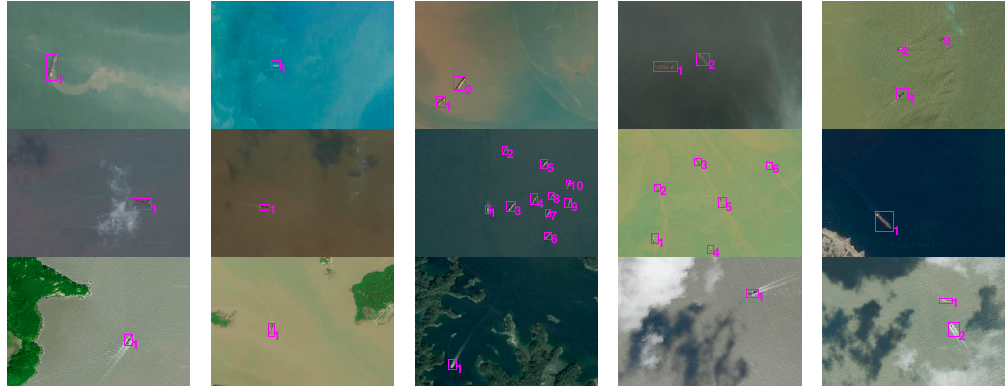
Figure16. The final detection results after the multi-level discrimination. Figure 16. The final detection results after the multi-level